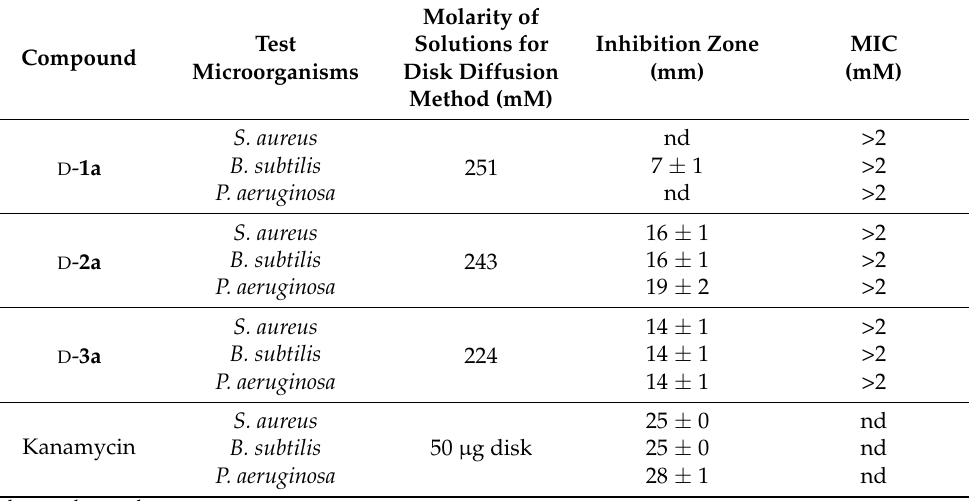
Table 2. Growth inhibition zones of the tested microorganisms and minimum inhibitory concentra- tions (MIC) of the tested compounds D - 1a , D - 2a, and D - 3a .